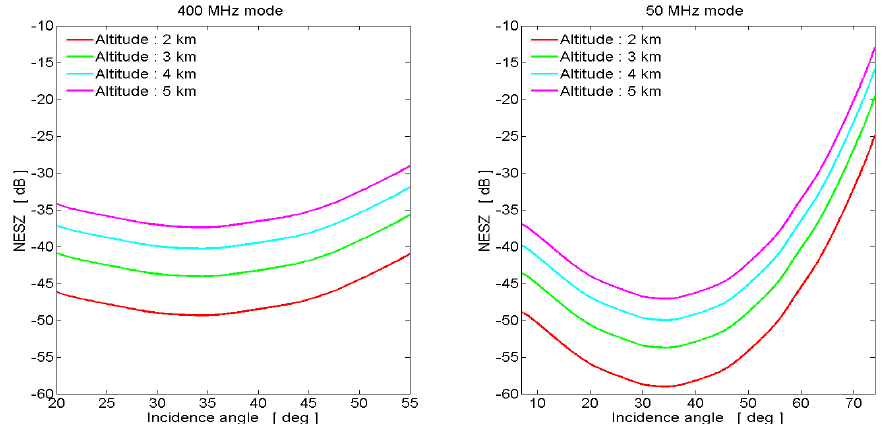
Figure 1. InSAeS4 Noise Equivalent Sigma Zero (NESZ) as a function of the incidence angle for the 400 MHz ( left ) and the 50 MHz ( right ) operational modes and for different flight altitudes.